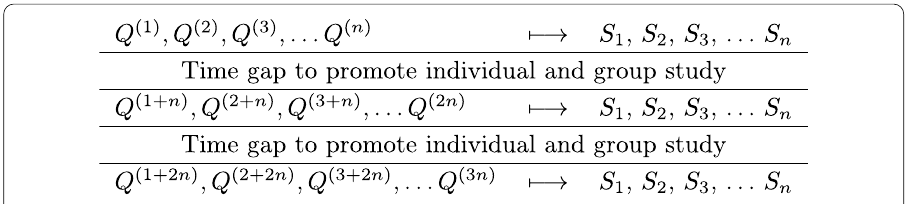
Fig. 5 Zingaro and Porter’s peer instruction model improved to use individualized assessments